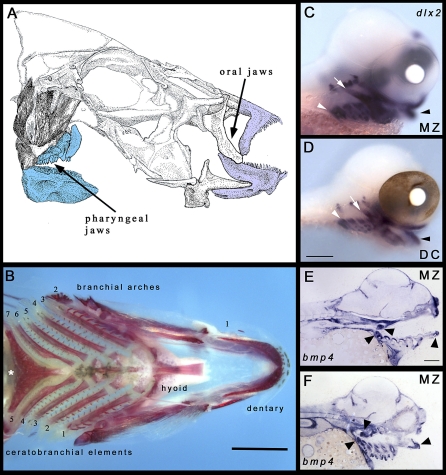
Malawi Cichlids Exhibit Toothed Oral and Pharyngeal Jaws(A) Schematic drawing (lateral view) of the generalized cichlid cranial skeleton, showing the relative location of the oral jaws (purple) and the pharyngeal jaws of PA7 (blue).(B) Dorsal view of an alizarin red skeletal preparation of the lower pharyngeal and oral elements of a juvenile D. compressiceps (DC) showing the series of branchial (pharyngeal) arches 1–7 and ceratobrachial elements CB1–5; the white asterisk indicates the toothed pharyngeal jaw. Scale bar represents 500 μm.(C and D) Lateral views with expression of dlx2 labeling neural crest-derived cells in the pharyngeal arches of M. zebra [MZ] (C) and D. compressiceps [DC] (D). Both cichlids are 4 dpf and to the same scale; scale bar in (D) represents 200 μm. dlx2 expression is observed throughout the arches from the mandibular arch, PA1 (black arrowheads), throughout the pharynx to the most posterior arch, PA7 (white arrowheads). dlx2 expression is also present in neural crest-derived mesenchymal cells that populate the arches (white arrows).(E and F) Sagittal sections of MZ (5 dpf) showing expression of bmp4 in multiple regions of the developing head and pharynx. bmp4 is expressed throughout the arches in neural crest-derived arch mesenchyme for each pharyngeal arch (PA1–7), including both the mesenchyme and epithelial components of the developing teeth (black arrowheads). (E) The medial sagittal section and (F) lateral sagittal section show the gill-bearing arches (PA3–6). Both (E and F) are to the same scale; scale bar in (E) represents 200 μm.